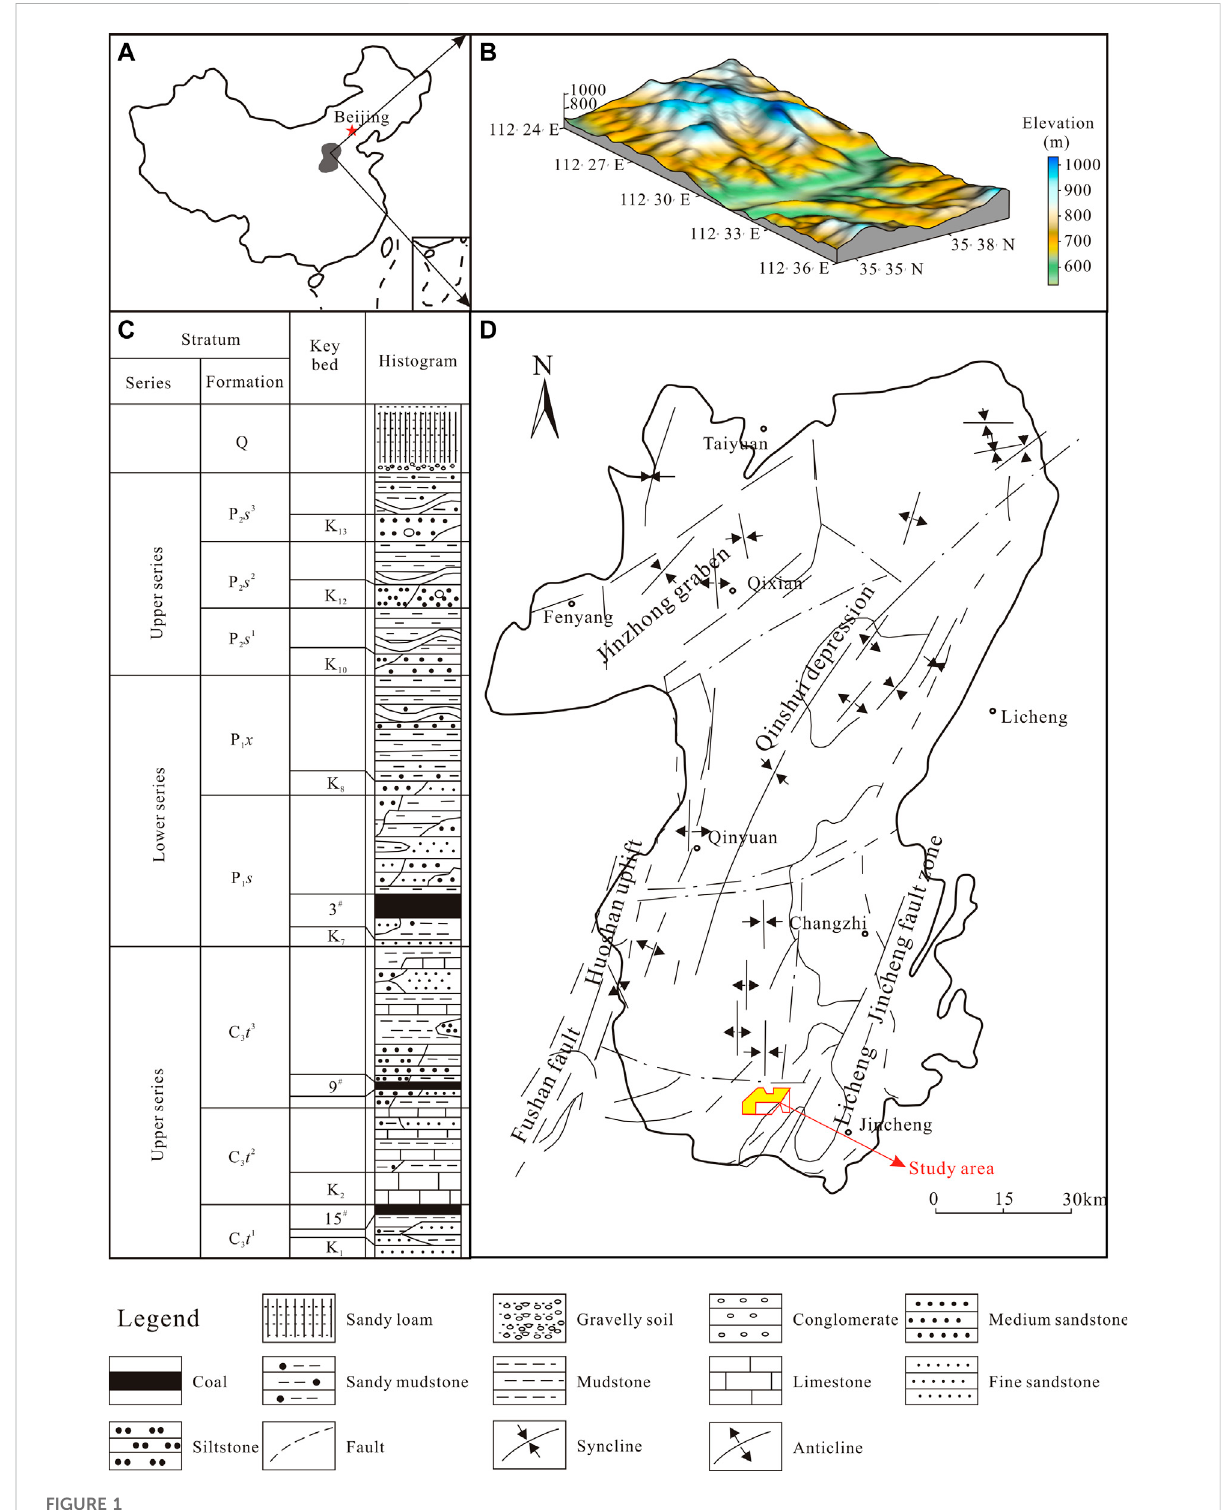
FIGURE 1 Schematic diagram of the PZ block in Qinshui Basin. (A) The location of the Qinshui Basin in China. (B) Geological schematic diagram of the PZ block. (C) Lithological column pro fi le of the PZ block. (D) Schematic diagram of the location and geological structure of the study